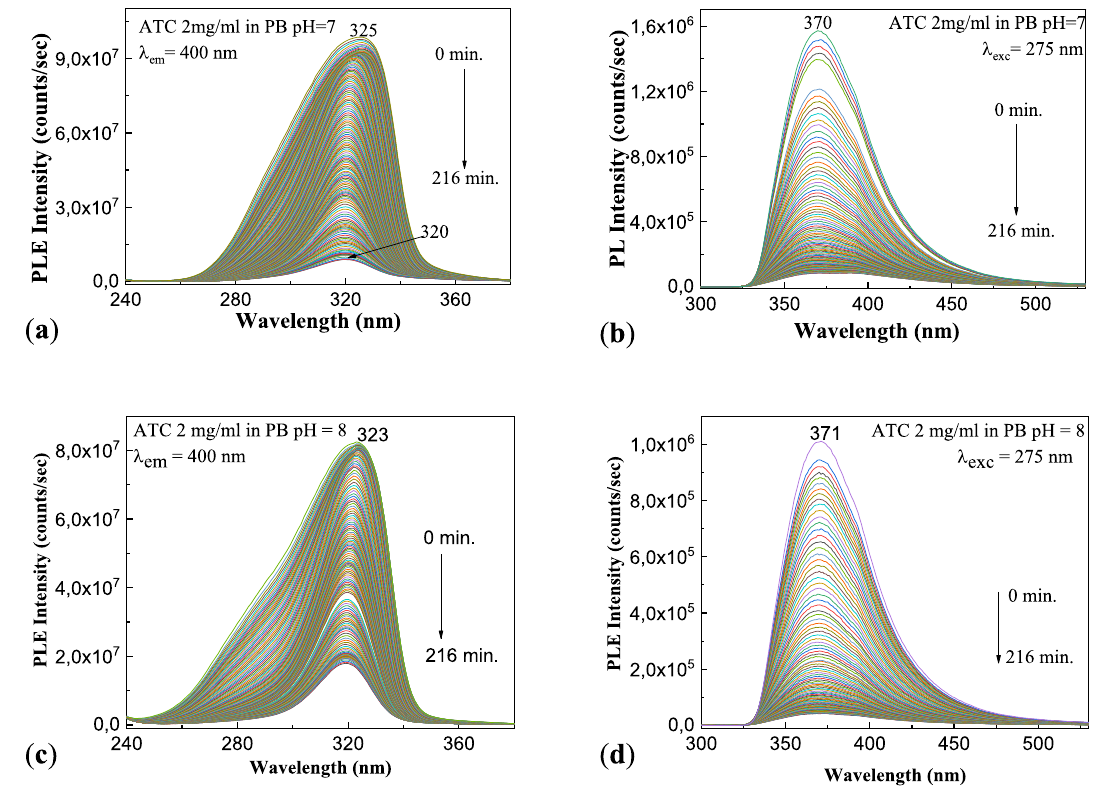
Figure 2. PLE and PL spectra ale ATC in initial state and after exposure at UV light, in the presence of PB with pH equal to 7 ( a , b ) and 8 ( c , d ), when the emission wavelength is equal to 400 nm and the excitation wavelength is equal to 275